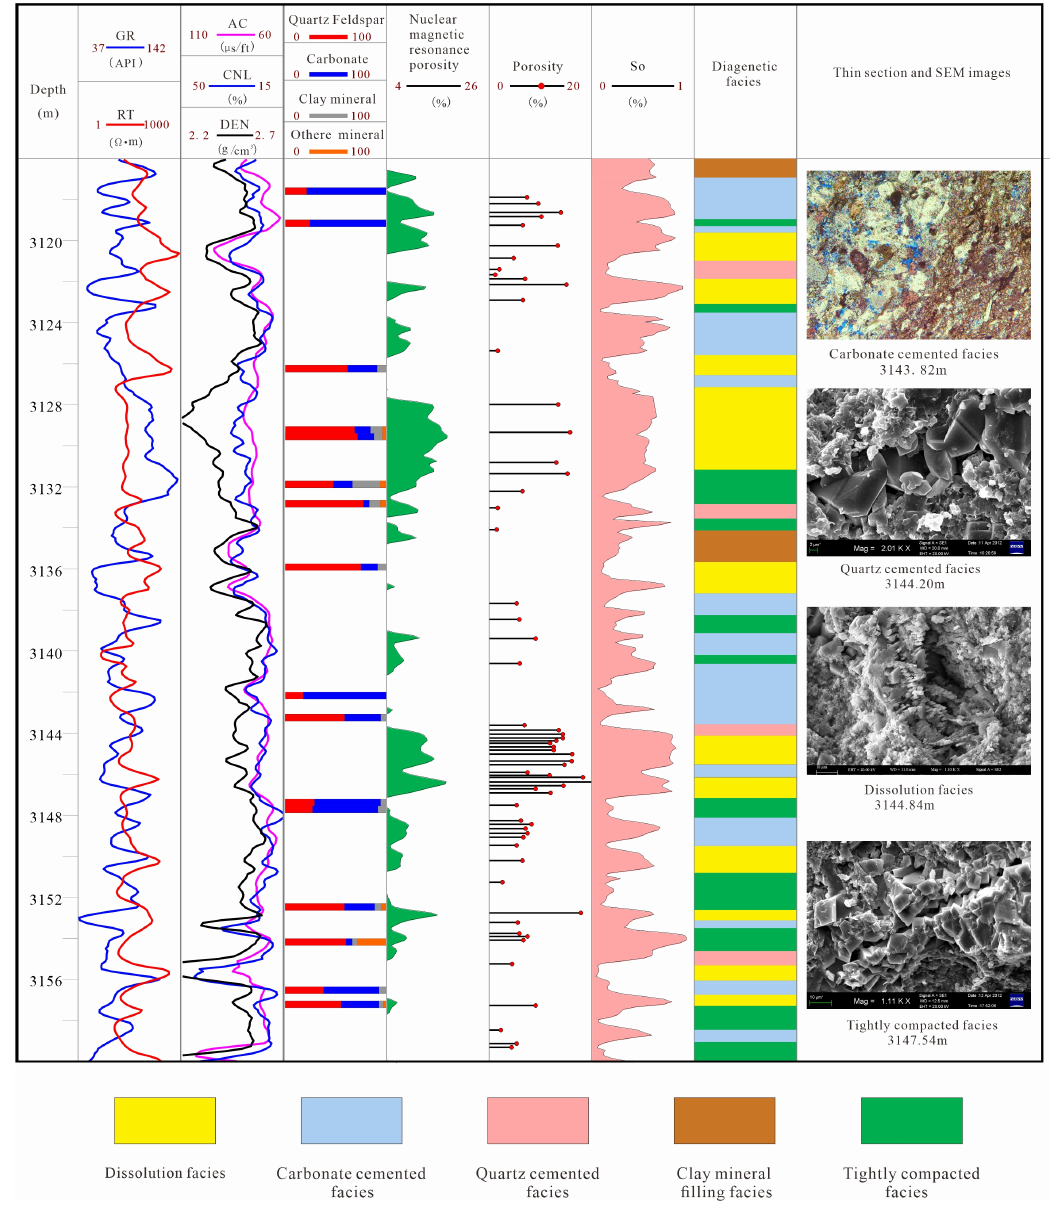
Figure 13. Well J174—single-well diagenetic facies prediction columnar diagram.